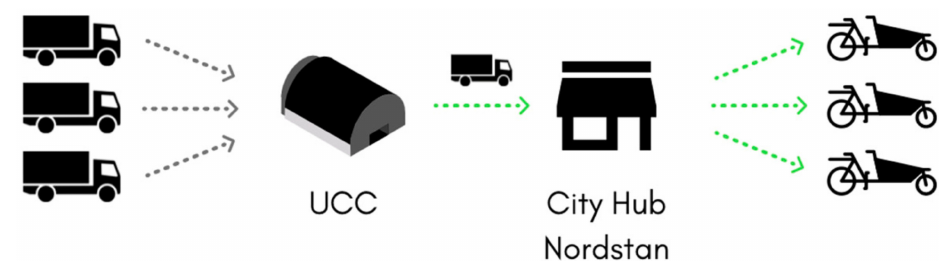
Figure 2. SMOOTh